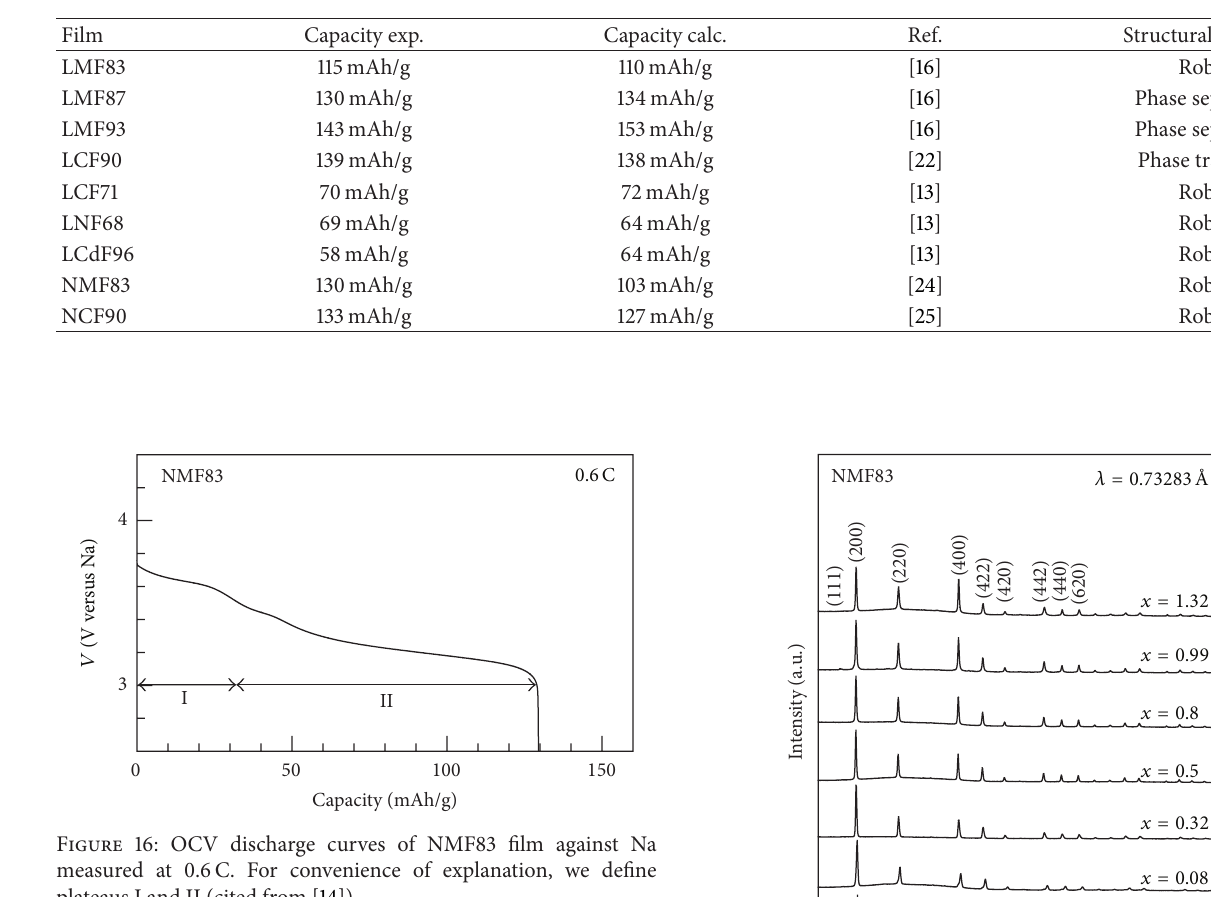
Table 4: Experimental and calculated capacities of PBA films together with the structural responses.